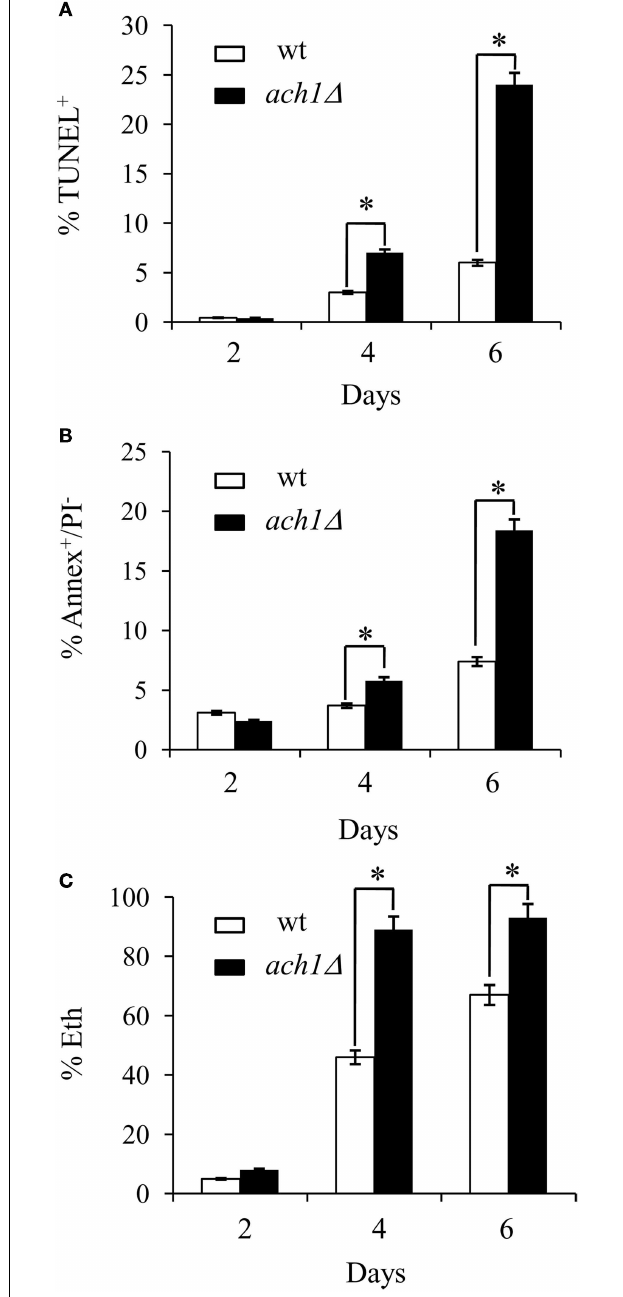
FIGURE 2 | Chronological aging ach1 ∆ cells display an early insurgence of apoptosis. Chronological aging cultures of Figure 1 at the indicated time-points were assessed for DNA fragmentation byTUNEL assay (A) , phosphatidylserine externalization and membrane integrity by AnnexinV/propidium iodide (PI) co-staining (AnnexV + /PI − , (B) and intracellular superoxide by dihydroethidium conversion into fluorescent ethidium (Eth), (C) . Summary graphs of the percentage of positive cells for each test are indicated. Evaluation of about 1000 cells for each sample in three independent experiments was performed. Standard deviations are indicated. Statistical significance between the strains is indicated ( ∗ P ≤ 0.001, Student’s t